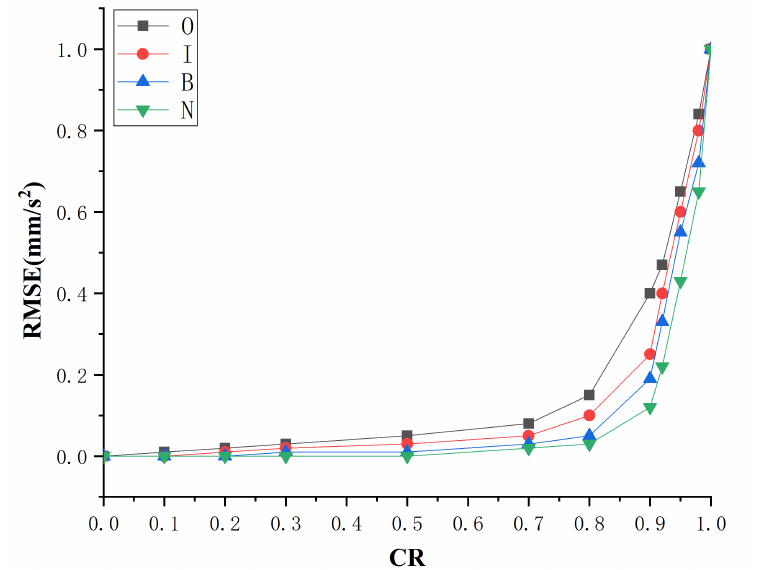
Figure 6. The RMSE curve of the reconstructed